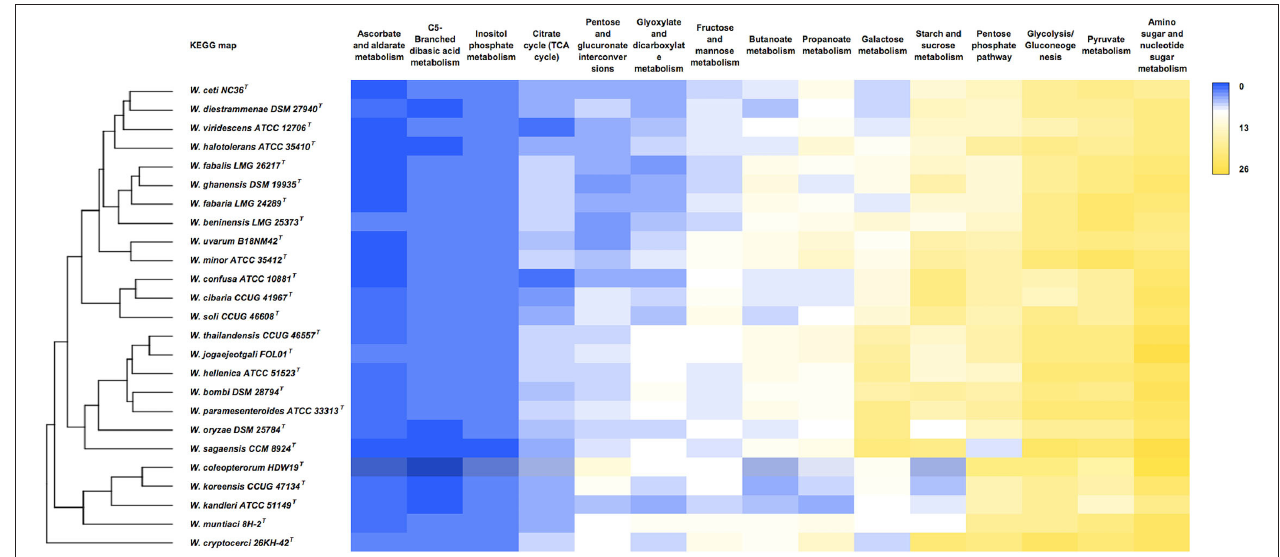
FIGURE 4 | Comparative analysis of carbohydrate metabolism in Weissella species. The heatmap was manually constructed based on the number of proteins associated with each KEGG pathway in each genome and visualized with the average linkage as a clustering method and the Euclidean distance measurement method, providing the resulting